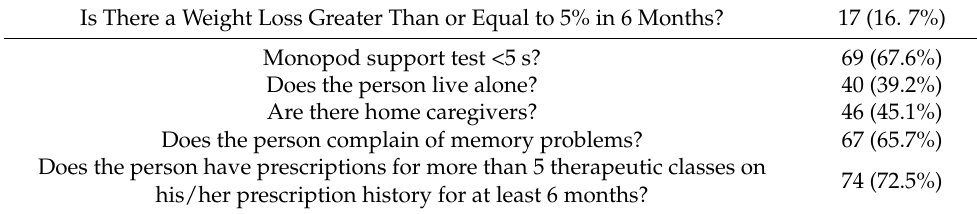
Table 8. Internal consistency of the questionnaire.